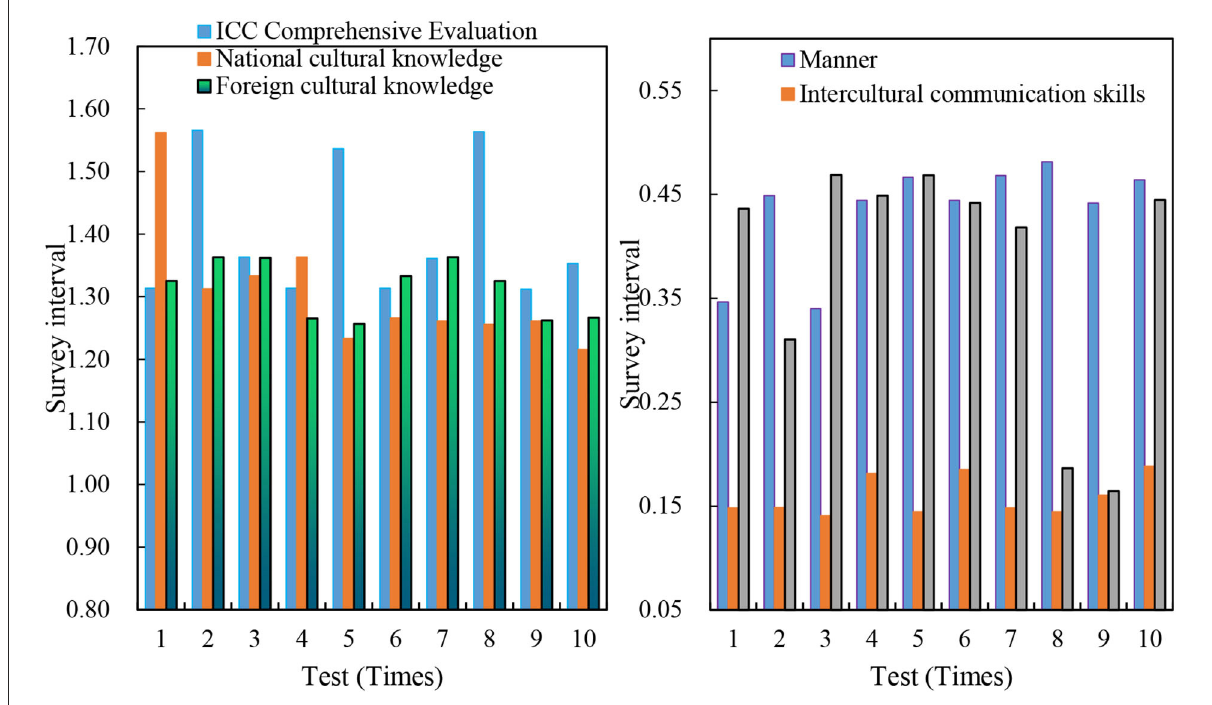
FIGURE6 Attitudes of college students with a score of 490–599 in CET-4.